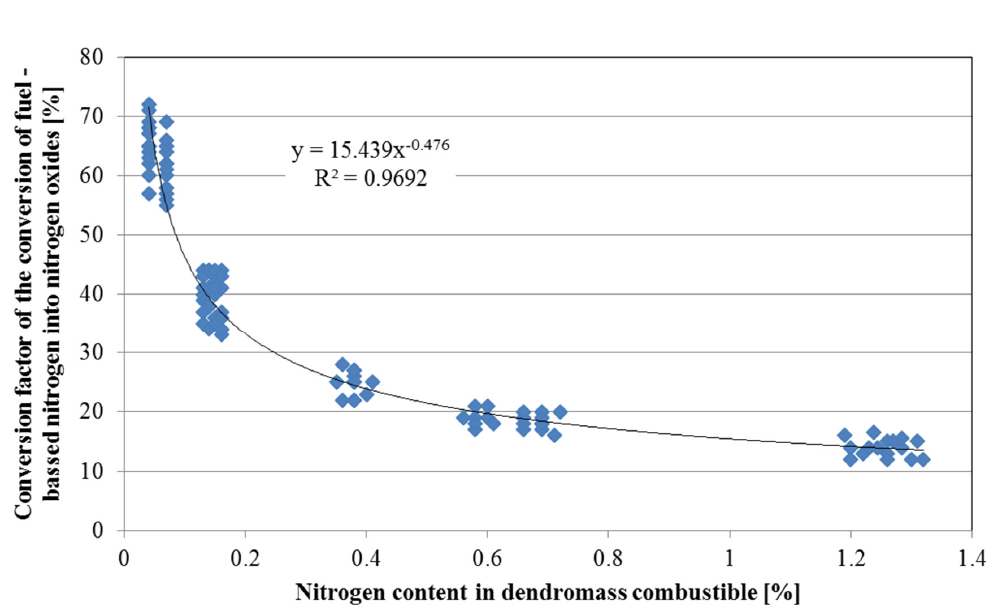
Quercus robur L.